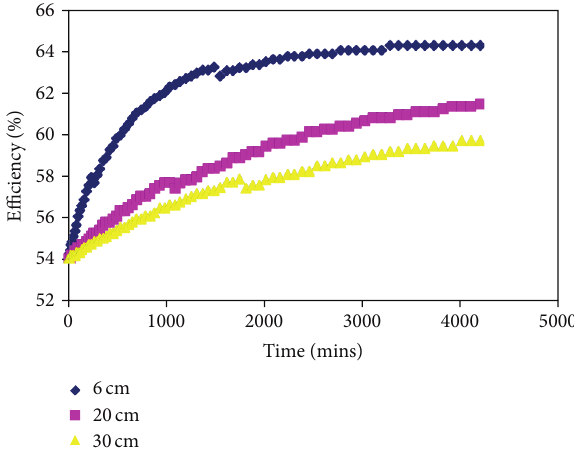
Figure 4: Impact of particle diameter on conversion efficiency.